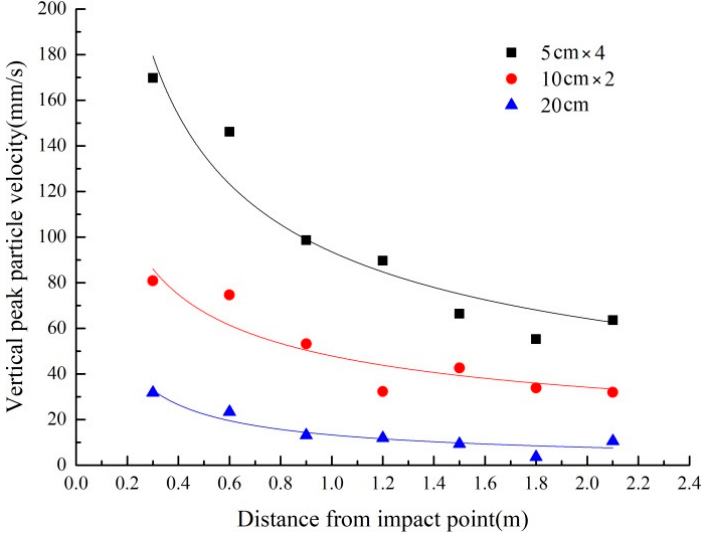
Figure 10. The impact test under the same thickness of layered medium and different number of slabs.